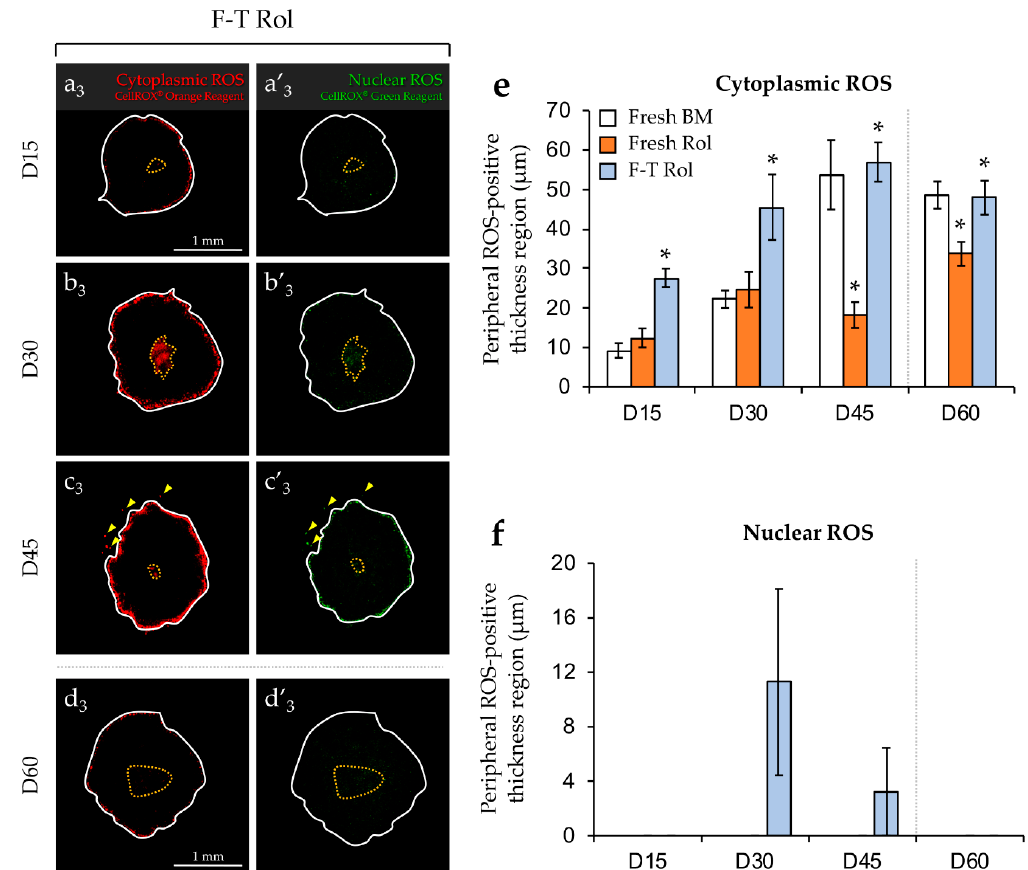
Figure 4. In situ detection of “cytoplasmic” and “nuclear” ROS generation at D15, D30, D45, and D60 in culture of fresh or frozen-thawed prepubertal testicular tissue using ex vivo imaging by confocal macroscopy. Fresh testicular fragments were cultured with ( a 1 ,a’ 1 ,b 1 ,b’ 1 ,c 1 ,c’ 1 ,d 1 ,d’ 1 ) or without ( a 2 ,a’ 2 ,b 2 ,b’ 2 ,c 2 ,c’ 2 ,d 2 ,d’ 2 ) Rol (retinol, vitamin A), whereas F-T testicular fragments were cultured only with Rol ( a 3 ,a’ 3 ,b 3 ,b’ 3 ,c 3 ,c’ 3 ,d 3 ,d’ 3 ). ( e ) The solid line delineates the outline of the testicular explant. The central necrotic area is delimited with a yellow dotted circle. ROS-positive cells (yellow arrows) were detected outside of the testicular explant at D45 for F-T Rol condition. Decreased fluorescence intensity was obtained for fresh testicular tissue with Rol when compared with BM at D45 and D60. ( f ) Increased fluorescence intensity was observed for F-T testicular fragments with Rol when compared with fresh tissue with Rol at D30 and D45. Green signal fluorescence was observed in a tight peripheral region of the F-T testicular tissues at D30 and D45 of culture. To visualize “cytoplasmic” (orange) and “nuclear” (green) ROS generation in testicular explants, the preparation was illuminated at 532 and 488 nm wavelength, respectively; fluorescence emission was detected from 550 to 580 nm and 500 to 530 nm, respectively. The values (µm) are expressed as the mean of the peripheral ROS-positive thickness region ± standard error of the mean (s.e.m.) of “cytoplasmic” or “nuclear” ROS under the different culture conditions tested, with n = 4. Asterisks indicate a statistically significant difference between fresh BM and fresh Rol or between fresh Rol and F-T Rol (* p < 0.05). BM, basal medium; D, day; F-T, frozen-thawed; Rol, retinol.